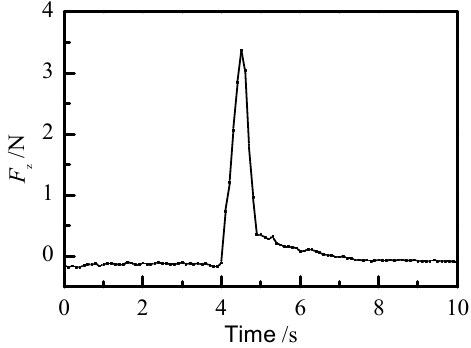
Figure 16. Force signal tracks in simulation.